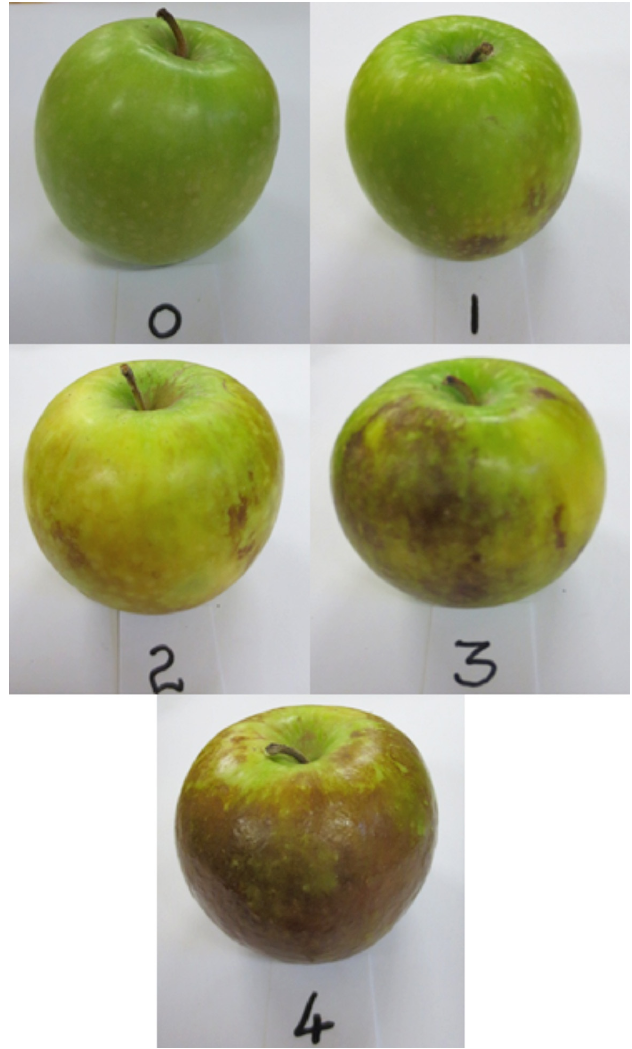
Fig. 1: ‘Granny Smith’ apples with different superficial scald severity: 0, no scald; 1, 1-25%; 2, 26-50%; 3, 51-75%; 4,